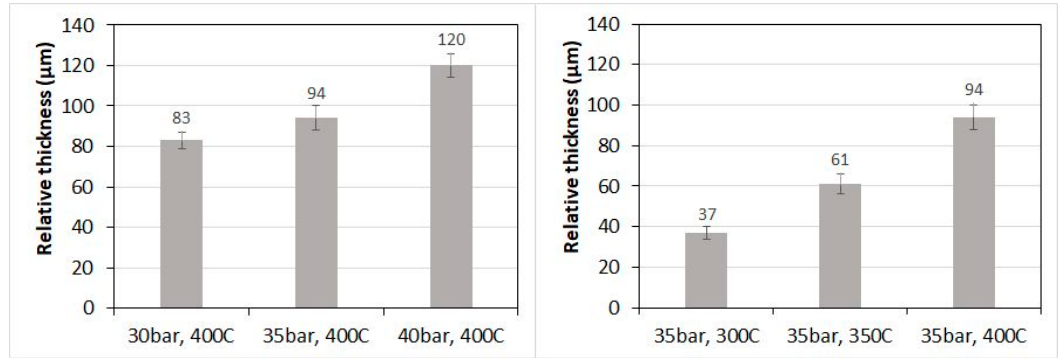
Figure 6. Relative thicknesses of the cold-sprayed Al6061 coatings sprayed with different spray parameters.